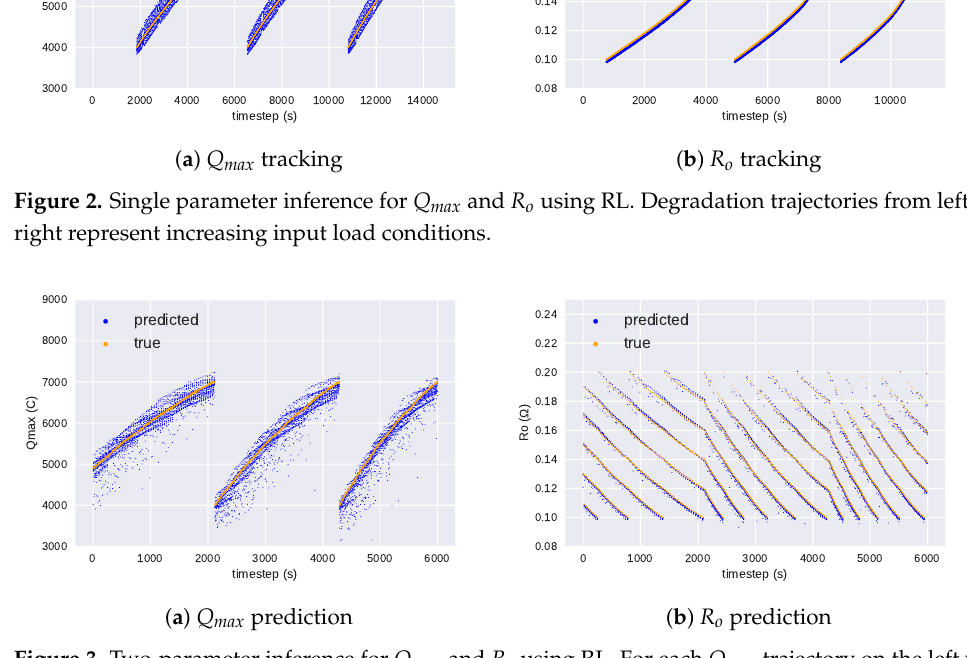
Figure 3. Two-parameter inference for Q max and R o using RL. For each Q max trajectory on the left we tryed multiple degradation values for R o on the